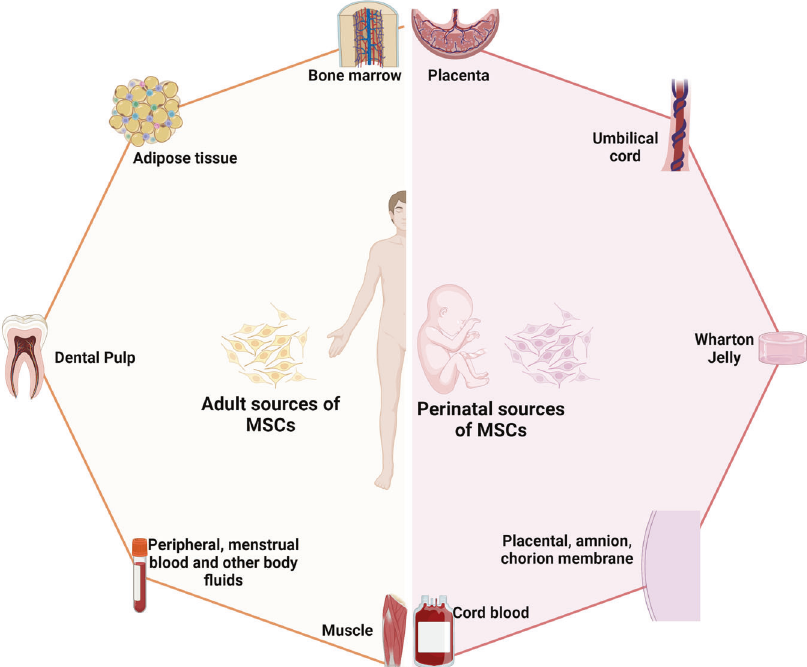
Fig. 2 The two major sources of MSCs: adult and perinatal sources. The adult sources of MSCs are speci fi c tissue in human body where MSCs could be isolated, including bone marrow, adipose tissue, dental pulp, peripheral blood, menstrual blood, muscle, etc. The perinatal sources of MSCs consist of umbilical cord-derived components, such as umbilical cord, Wharton ’ s jelly, umbilical cord blood, and placental structures, such as placental membrane, amnion, chorion membrane, amniotic fl uid, etc. The fi gure was created with